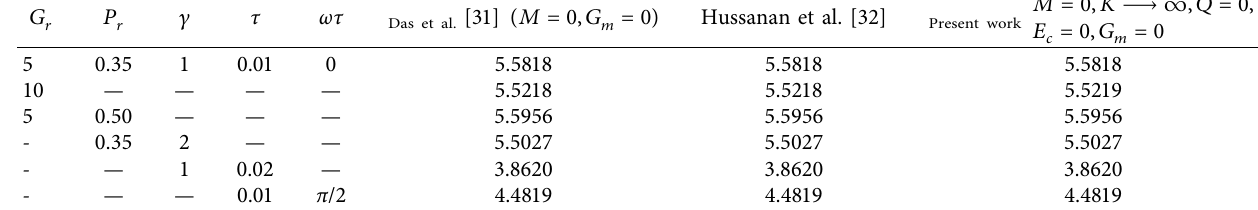
Table 1: Comparison of the skin friction coefficient calculated in the present work with published works.